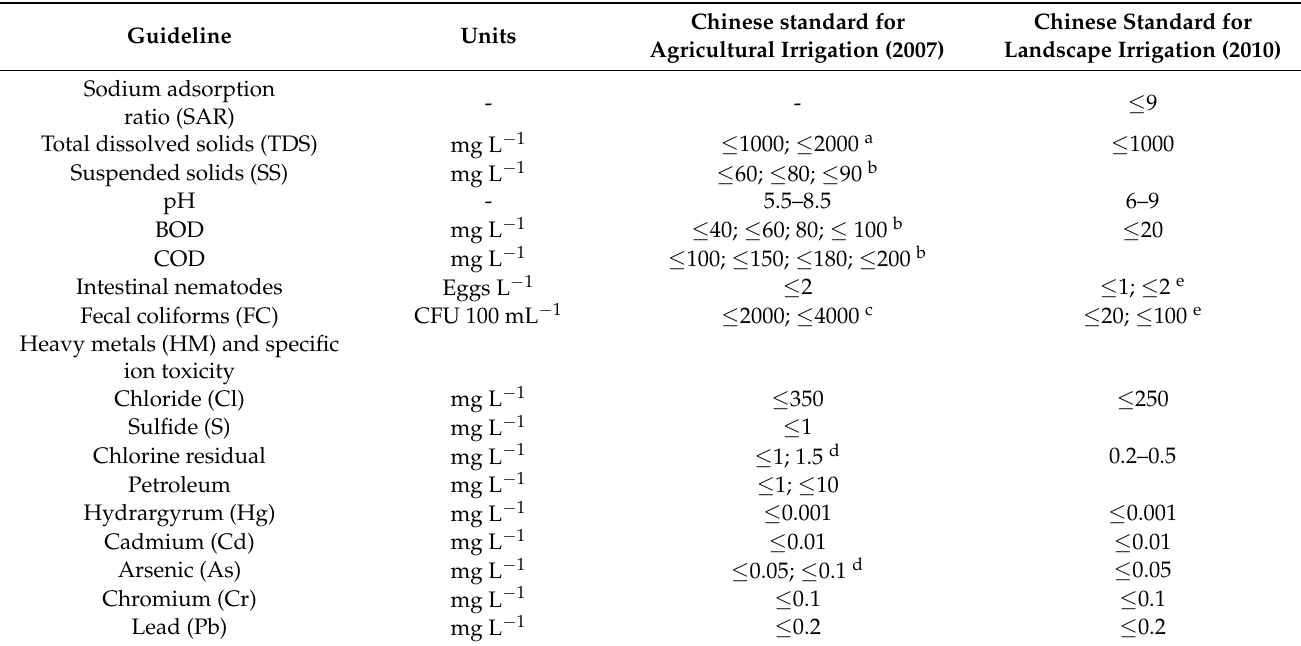
Table 5. Chinese water quality standard for TW irrigation